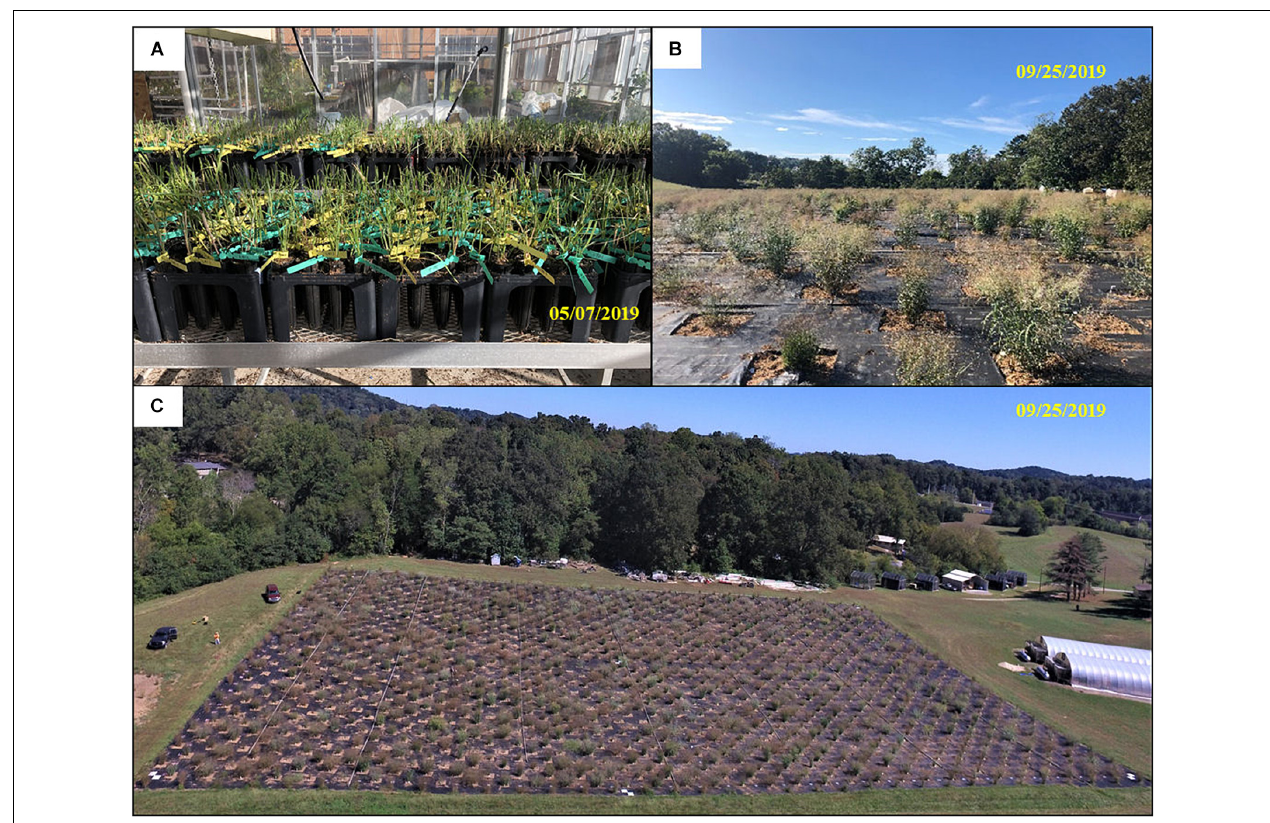
FIGURE 1 | Switchgrass field establishment. (A) The 330 switchgrass accessions in pots awaiting transplanting to the field; (B,C) status of switchgrass growth nearly 4 months after transplantation into the field site.